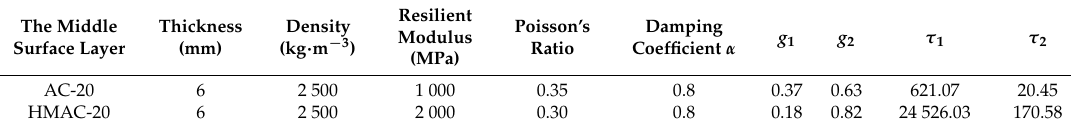
Table 6. Comparison of material parameters in the middle surface layer.